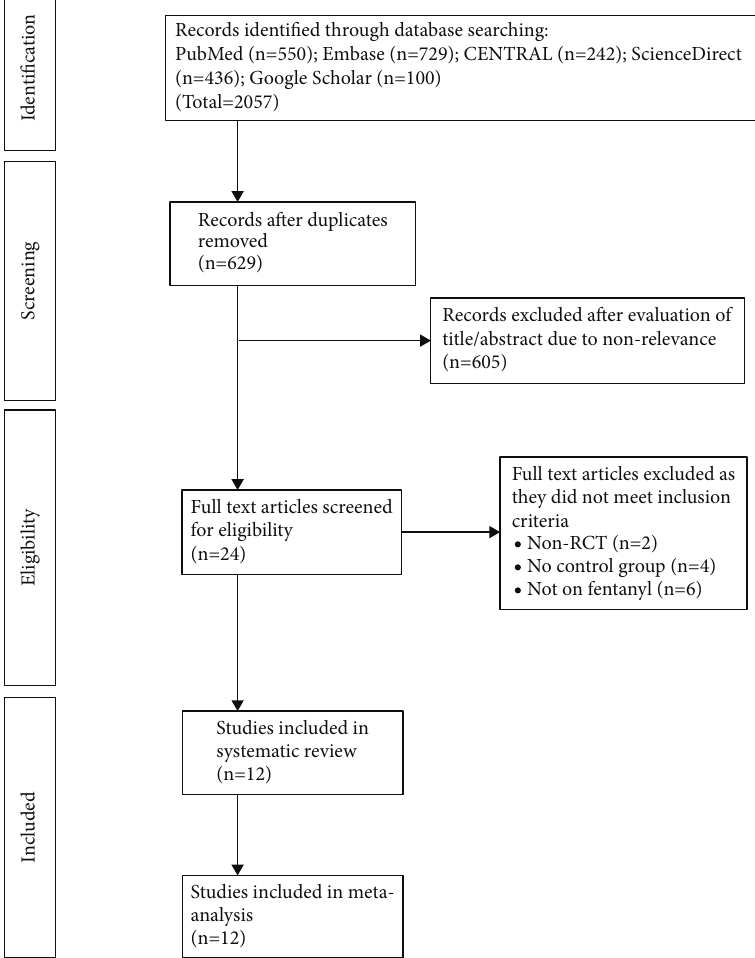
Figure 1: Study flow